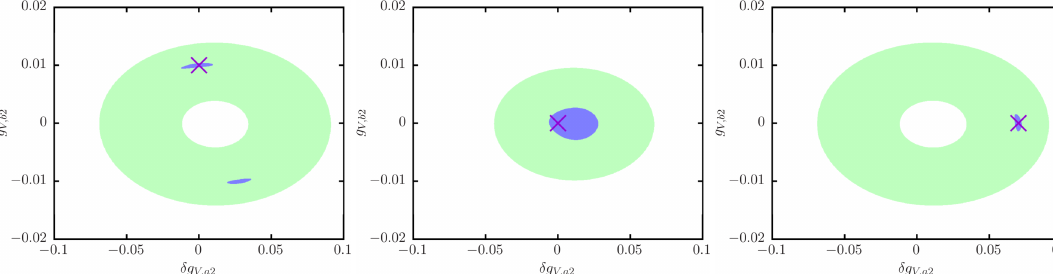
) = (0 , 0) , (0 . 07 , 0) , (0 , 0 . 01) , g true V,a 2 V,b 2